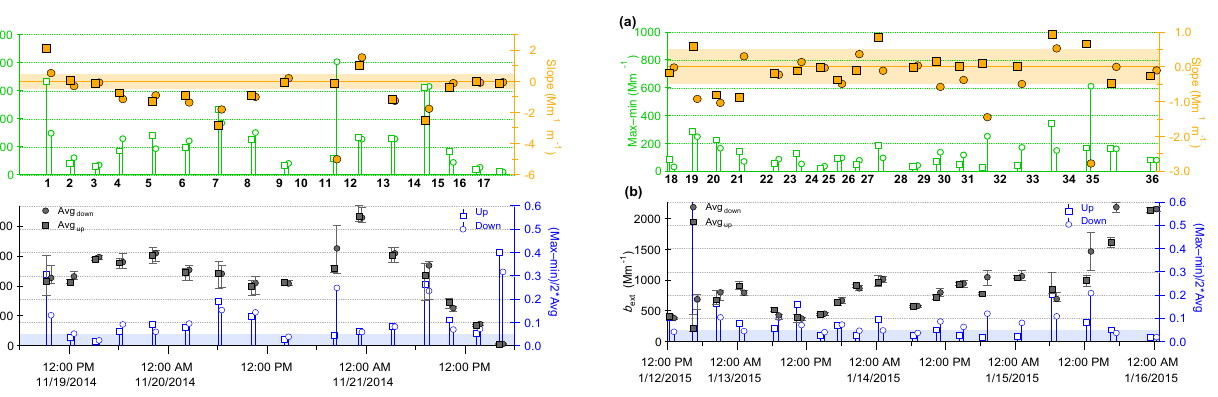
four types of vertical profiles is presented in Tables S2–S5. 1. Uniform vertical distributions. As shown in Fig. 4a, the vertical variations for the three vertical profiles of b ext were small, and the vertical differences were all less than 5 %, indicating that aerosol particles were